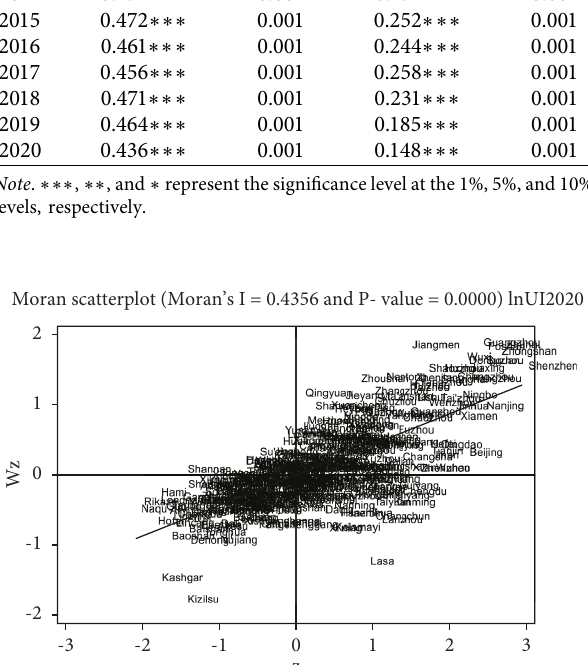
Figure 1: Moran’s I in spatial clustering of urban innovation in